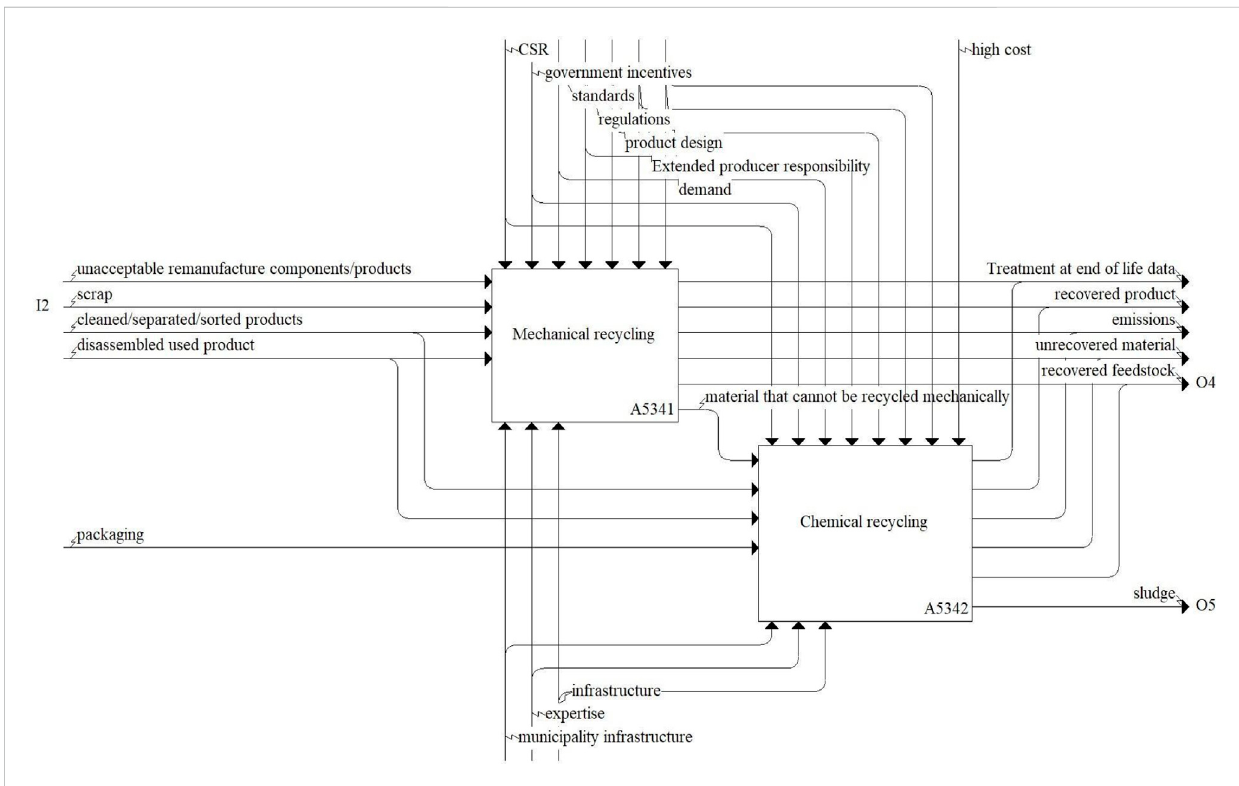
Recycle phase in the context of a manufacturing CE IDEF0